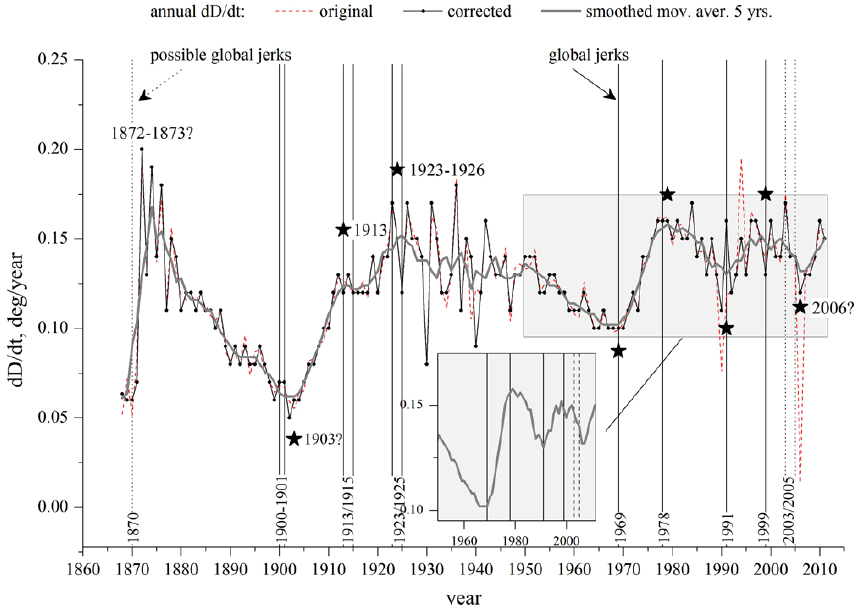
Fig. 15. Secular variation of COI D : original data – red dashed line, corrected – black line with dots, smoothed by 5yr moving averaging – grey thick line. Vertical lines show dates of global jerks (solid) and possible global jerks (dotted). Stars identify jerks seen in COI D data. Grey rectangles single out the period of corrected